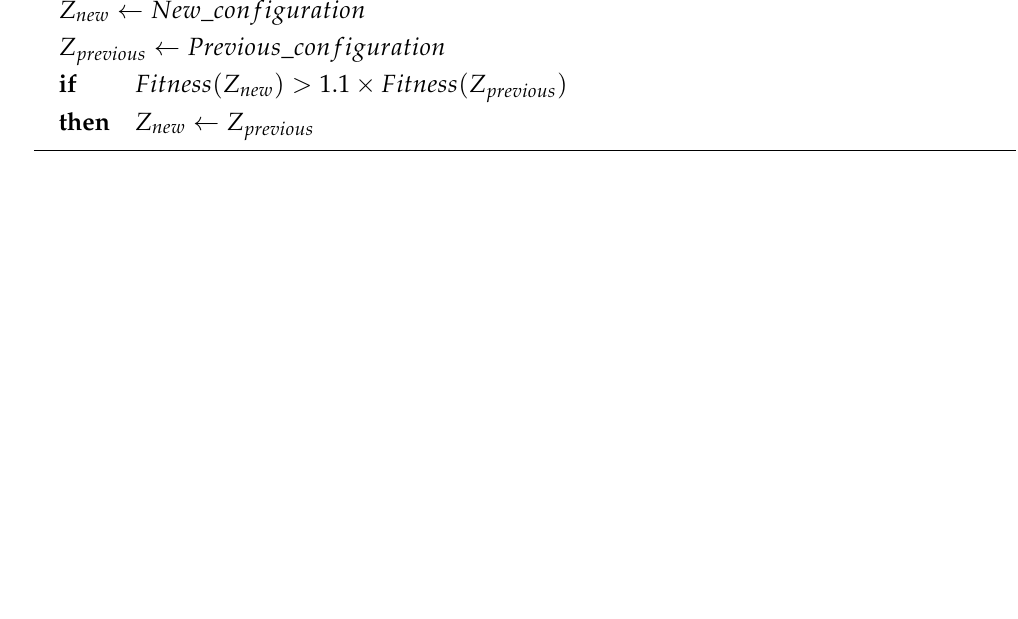
Algorithm 1 Screening low-quality